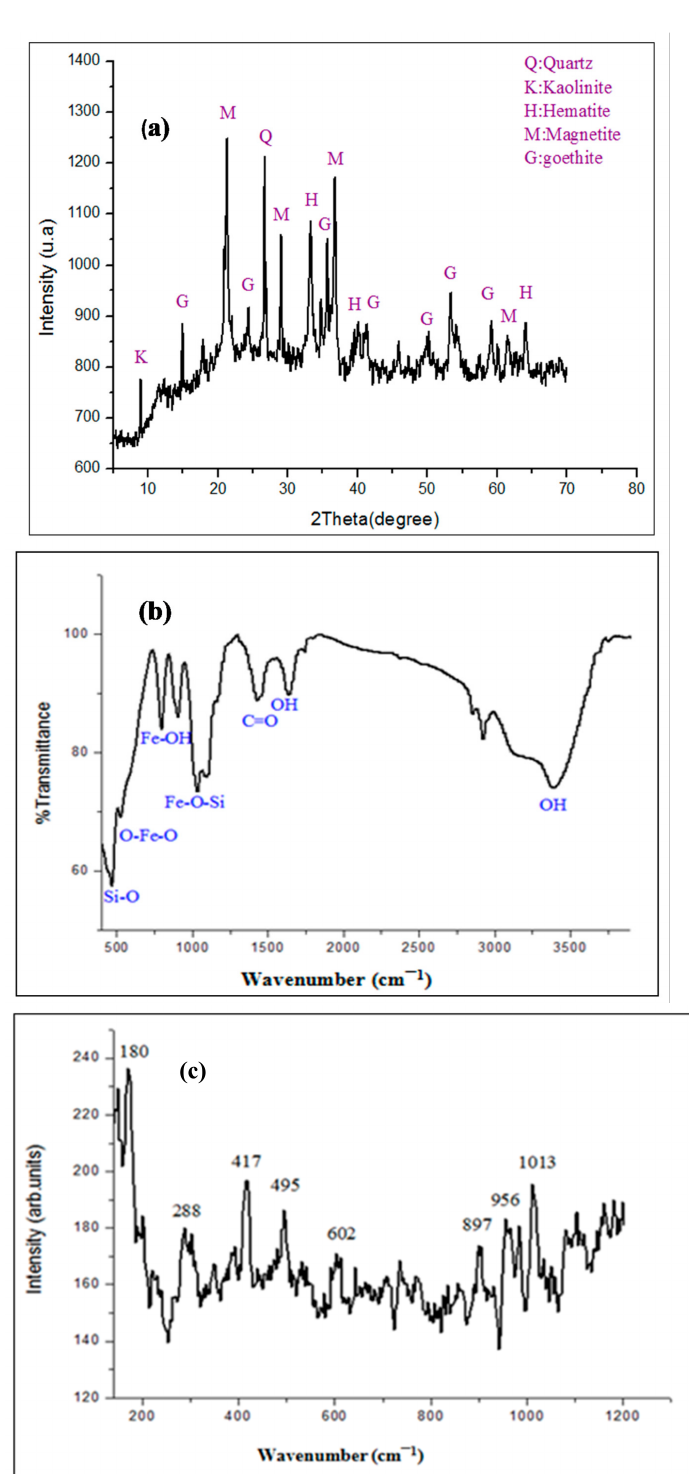
Figure 1. XRD pattern ( a ), IR spectrum ( b ), and Raman spectrum ( c ) of the catalyst. Raman spectrum of the catalyst (Figure 1c) in the wavelength range of 150–1200 cm − 1 is characterized by many peaks. Bands at 180 cm − 1 and 288 cm − 1 are attributed to hematite phase in the natural iron oxide [27]. Magnetite phase is mostly identified by the existence of a band at 602 cm − 1 [28]. Bands at 417 and 495 cm − 1 can be assigned to goethite phase, as reported in previous studies [29,30]. The two bands at 956 and 1013 cm − 1 are associated with Siderite phase